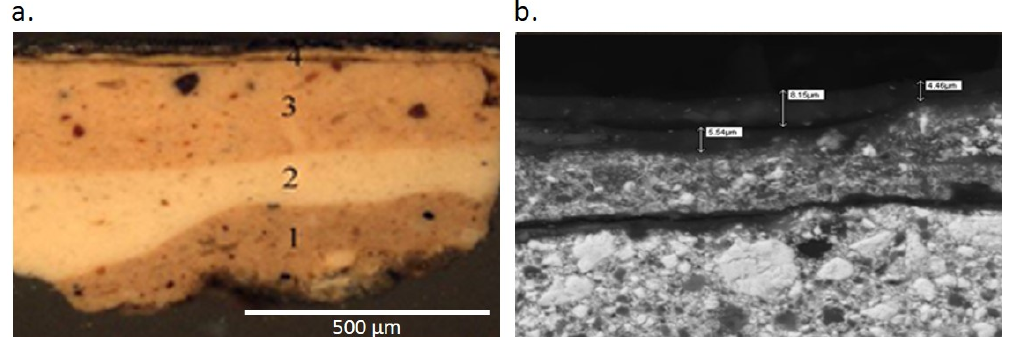
Figure 4. Stratigraphy of Sample EXPQ1 from the leg. ( a ). Optical microphotography shows the presence of four layers. ( b ). SEM-EDX detail of the upper layers that contained two layers of acrylic resin with iron oxide pigments applied in the last restoration to homogenize the color Table 1. Results of traditional techniques (OM, SEM-EDX, FTIR).